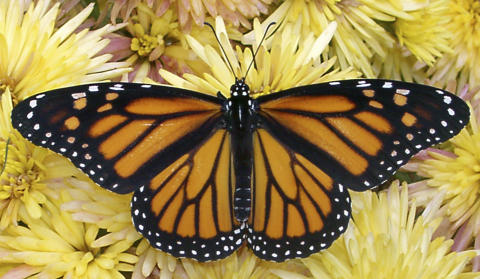
Two cryptochrome proteins, which act as critical components in an ancestral circadian clock mechanism characterized in monarch butterflies, may also connect the clock to the sun compass for successful navigation